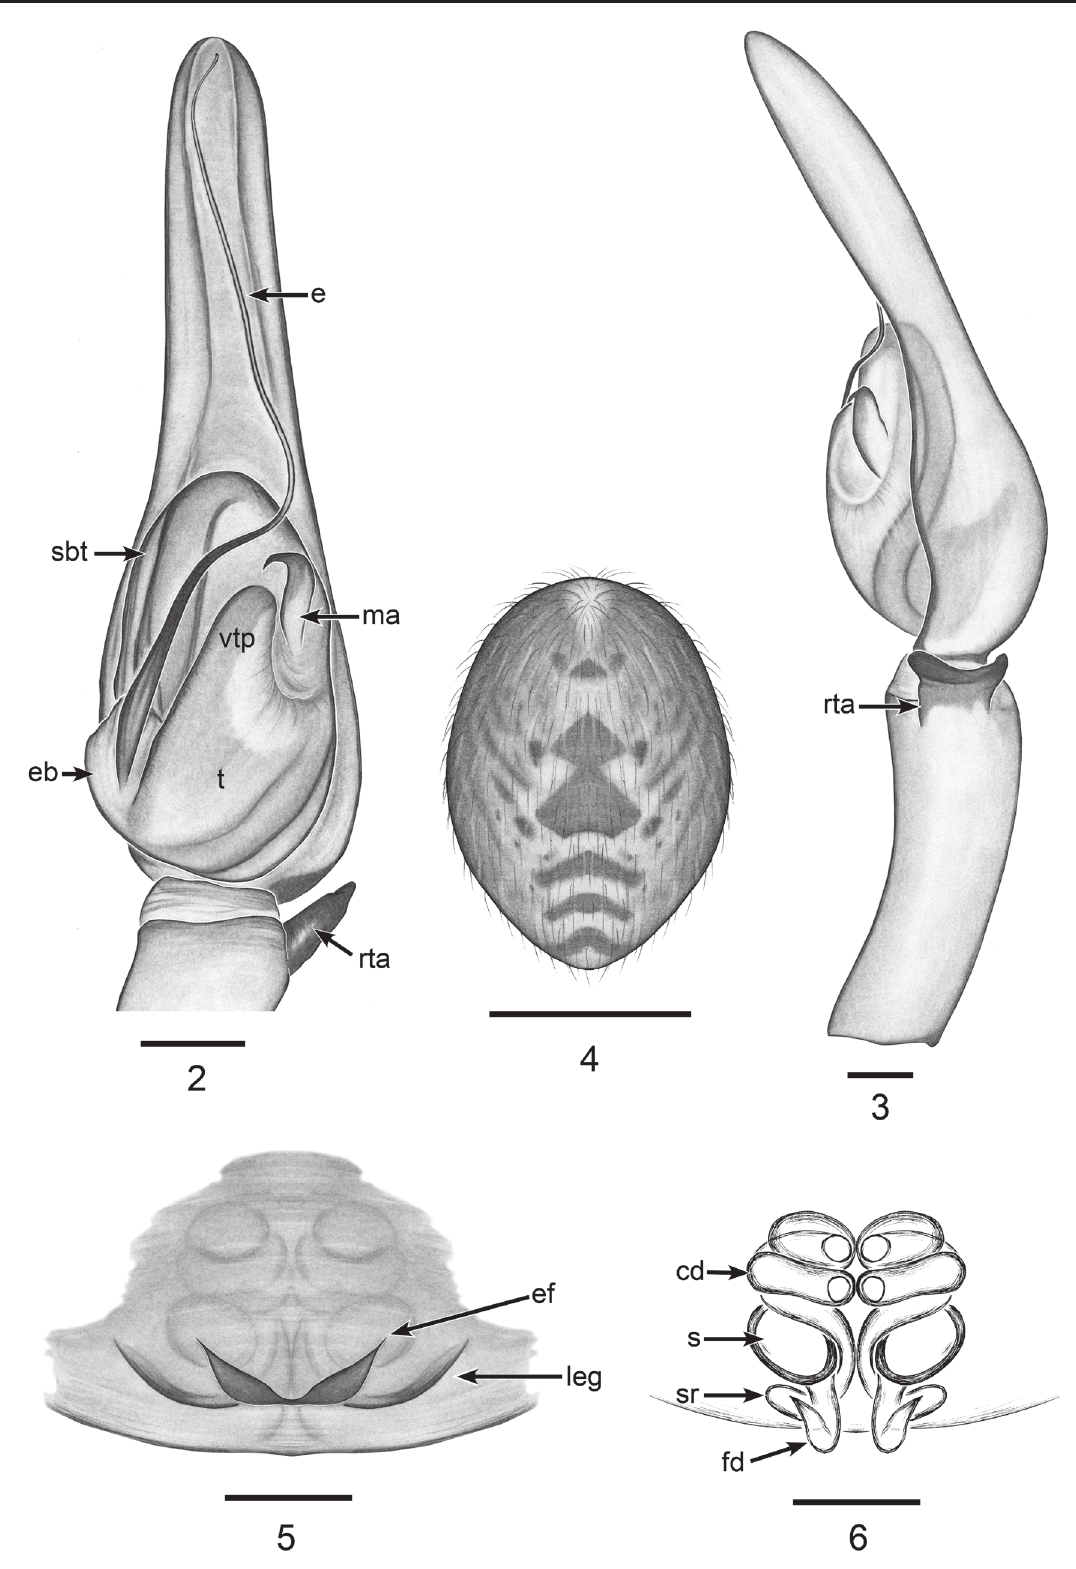
Figs 2–6. Katissa kurusiki sp. nov. 2 . ♂, palp, ventral view. 3 . ♂, palp, retrolateral view. 4 . ♀, abdomen, dorsal view. 5 . ♀, epigynum, ventral view. 6 . ♀, internal genitalia, dorsal view. Scale bars: 2–3, 5–6 = 0.1 mm; 4 = 1